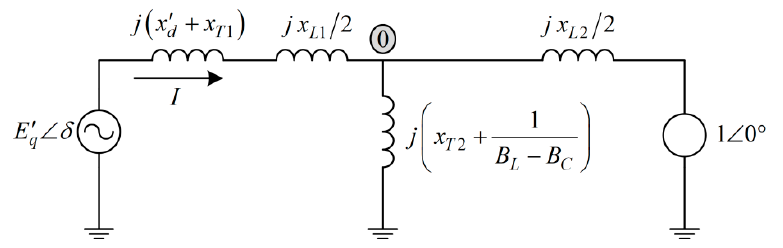
Figure 2. Pre-fault equivalent circuit.